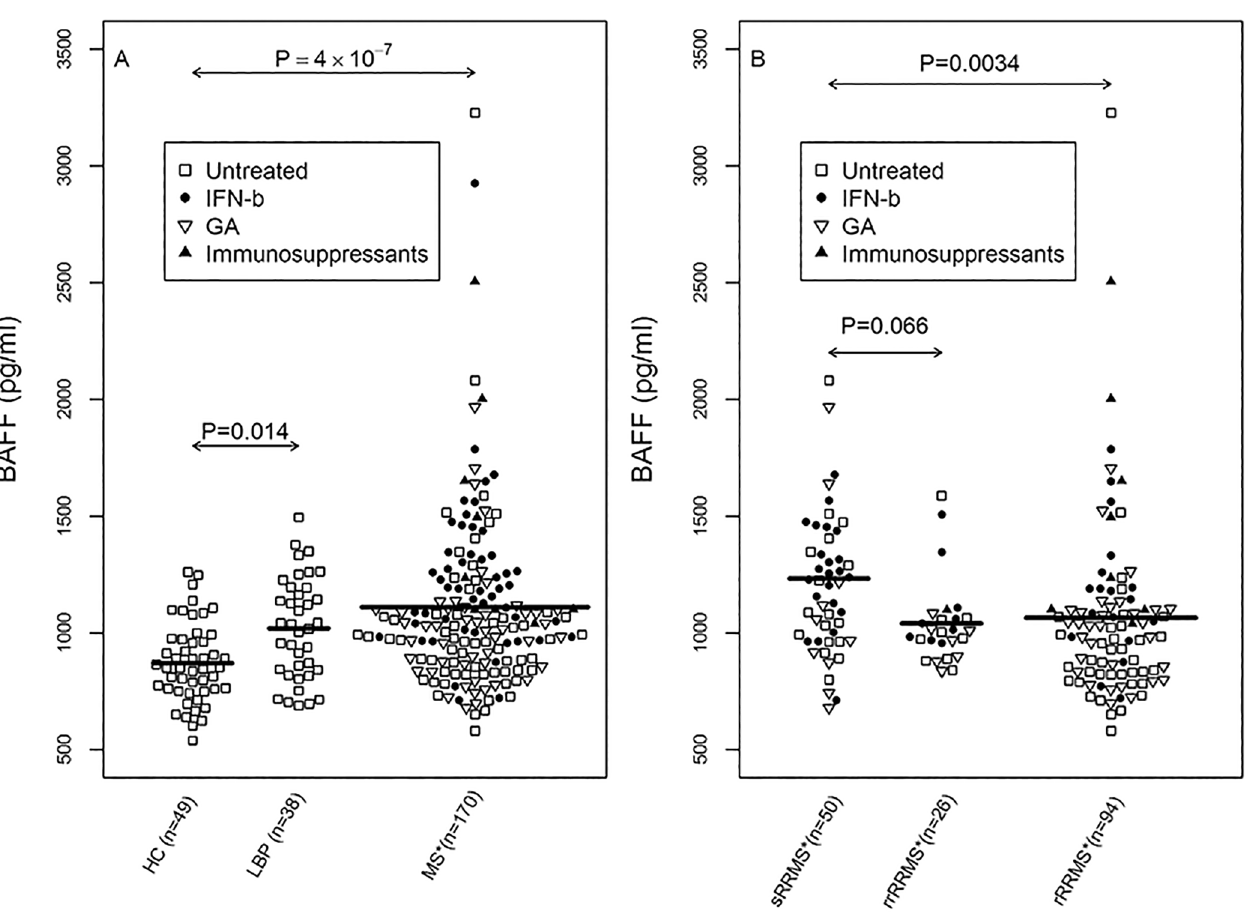
Fig 1. Average B cell-activating factor (BAFF) levels in the plasma of multiple sclerosis (MS) patients and controls. Bee Swarm plot of: (A) Plasma BAFF levels in healthy controls (HC group), patients with lower back pain (LBP group), and all MS patients. (B) Plasma BAFF levels in MS patient subgroups: stable MS patients (sRRMS), remission-relapsing MS patients (rrRRMS), and relapsing MS patients (rRRMS). Means and the results of Tukey HSD test are shown. Untreated ( □ ) and IFN- β ( ● ), GA ( ▽ ) or immunosuppressant ( ▲ ) treated individuals. * Average concentration of BAFF in patients during the follow-up